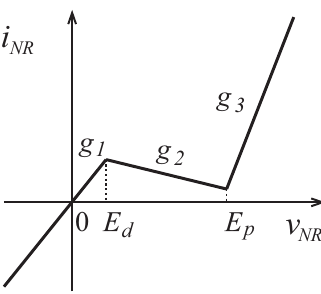
Figure 4. v NR − i NR characteristic of Modeled Tunnnel Diode 3SPWL resistor.